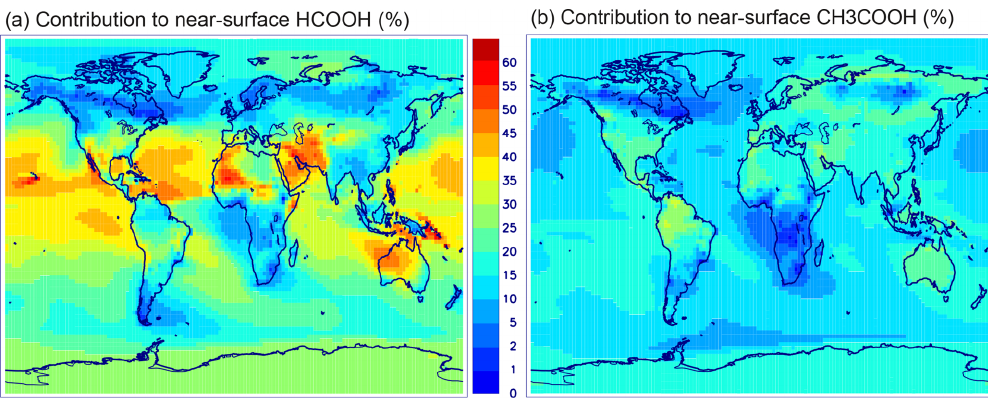
Figure 10. Calculated percentage contribution of hydroperoxycarbonyl photolysis to near-surface concentrations of (a) formic and (b) acetic acid for the month of July.